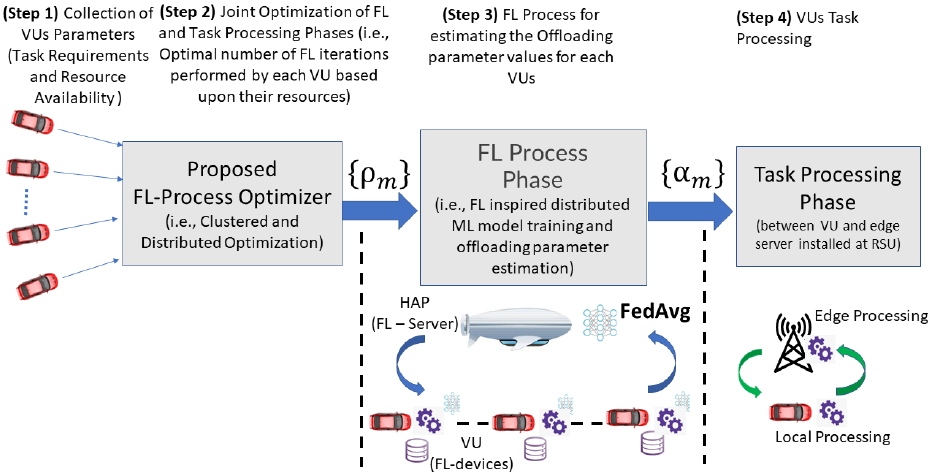
Figure 6. Proposed scheme for the joint FL and task-offloading processes optimization. Reprinted/adapted with permission from Ref. [71]. ©2022,